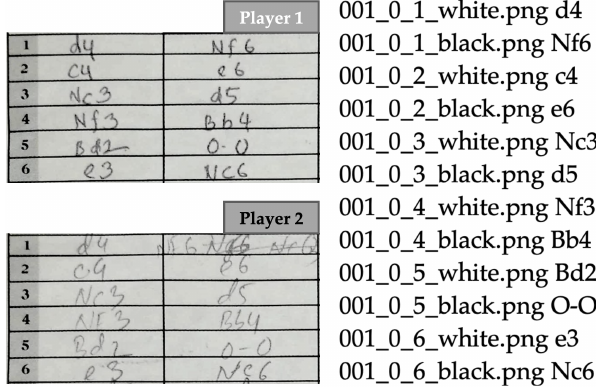
Figure 12. Cropped samples of raw images ( left ) and associated ground truth labels ( right ) from the HCS dataset [23].